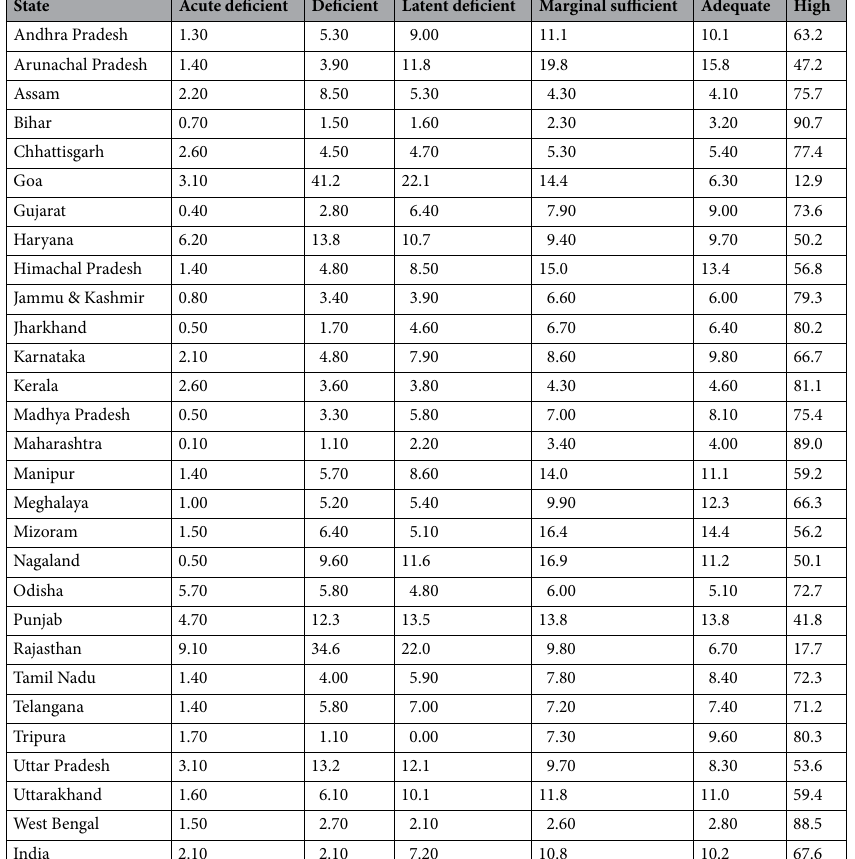
Table 6. State-wise deficiency (% of soil samples) status of available